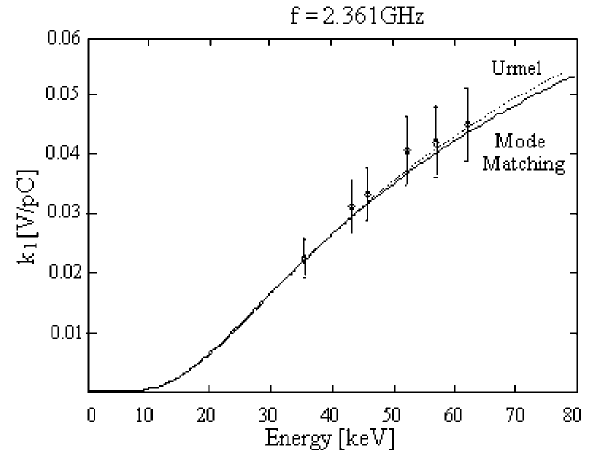
FIG. 6. Loss factor as a function of bunch energy; comparison between theoretical and experimental results at f (cid:1) 2361